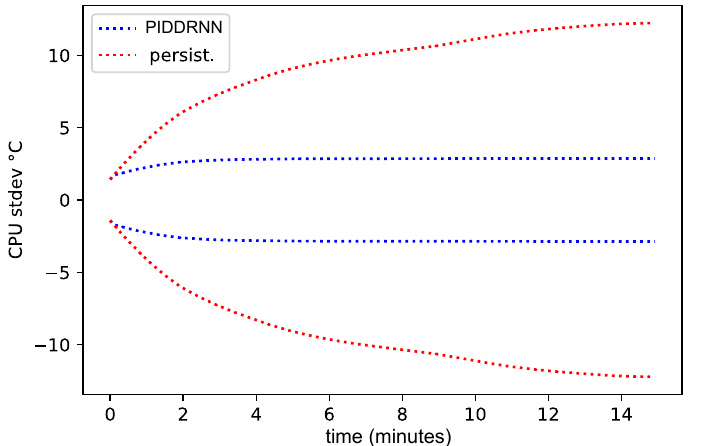
Figure 7. The standard deviation of the CPU test-set prediction error increases with the length of the prediction horizon. For the PIDD RNN model, its envelope quickly reaches a stable width, visibly narrower than that for the persistence model.